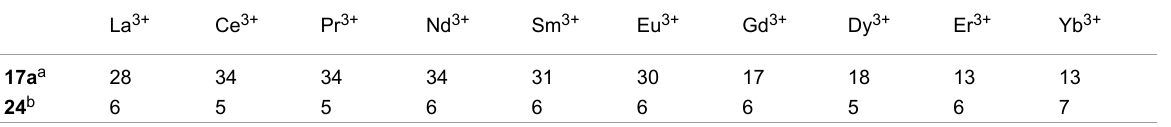
Table 5: Percentage extraction of lanthanide-metal picrates into CH 2 Cl 2